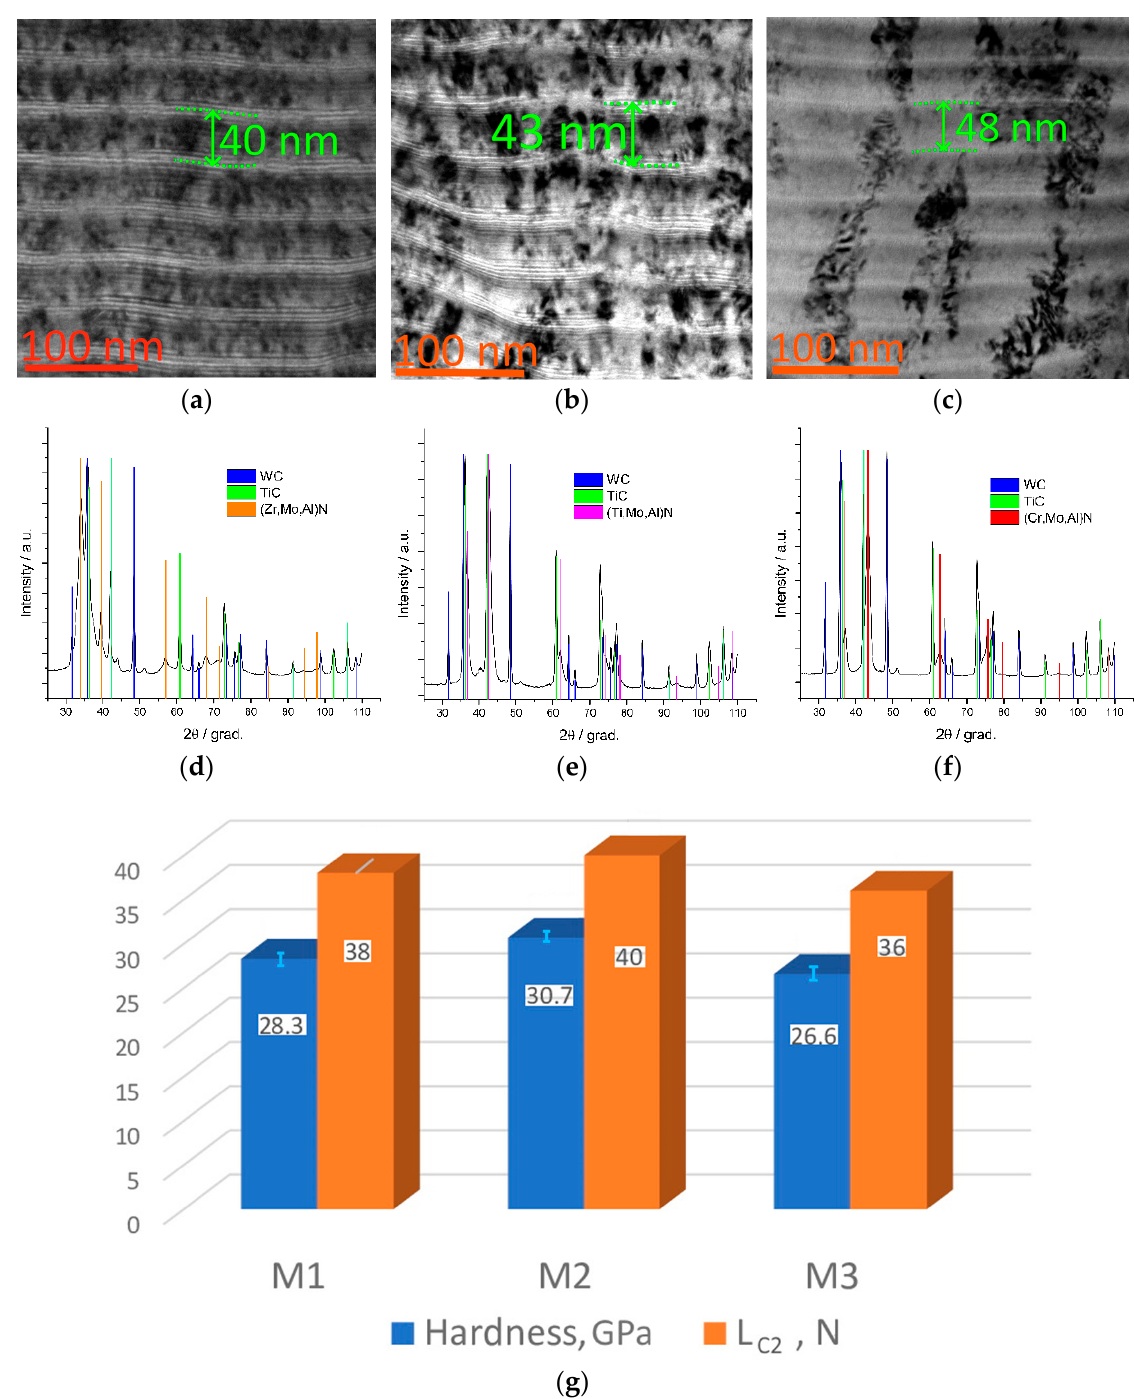
Figure 1. Parameters of the nanostructure of Coatings: ( a ) M1, ( b ) M2, ( c ) M3; XRD phase analysis of Coatings: ( d ) M1, ( e ) M2, ( f ) M3; ( g ) comparison of the values of hardness and the fracture threshold stress values in scratch testing.